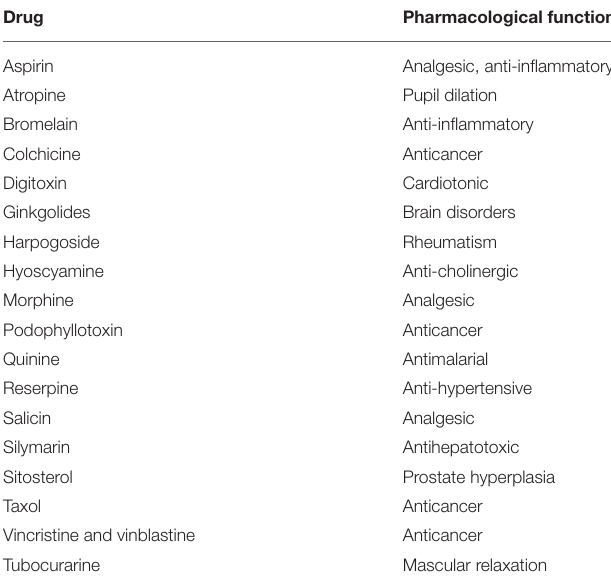
TABLE 2 | Medicinal products derived from plants.